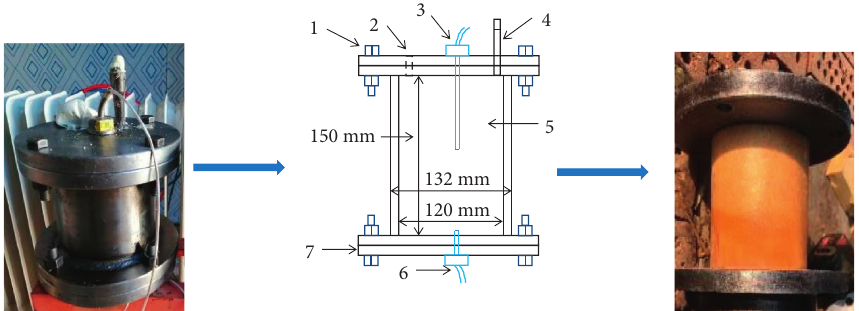
Figure 6: Grouting mold. (1) Bolt; (2) vent hole; (3, 6) temperature sensor; (4) grouting hole; (5) reaction vessel; (7) flange plate. Temperature sensor (WZP-26S)